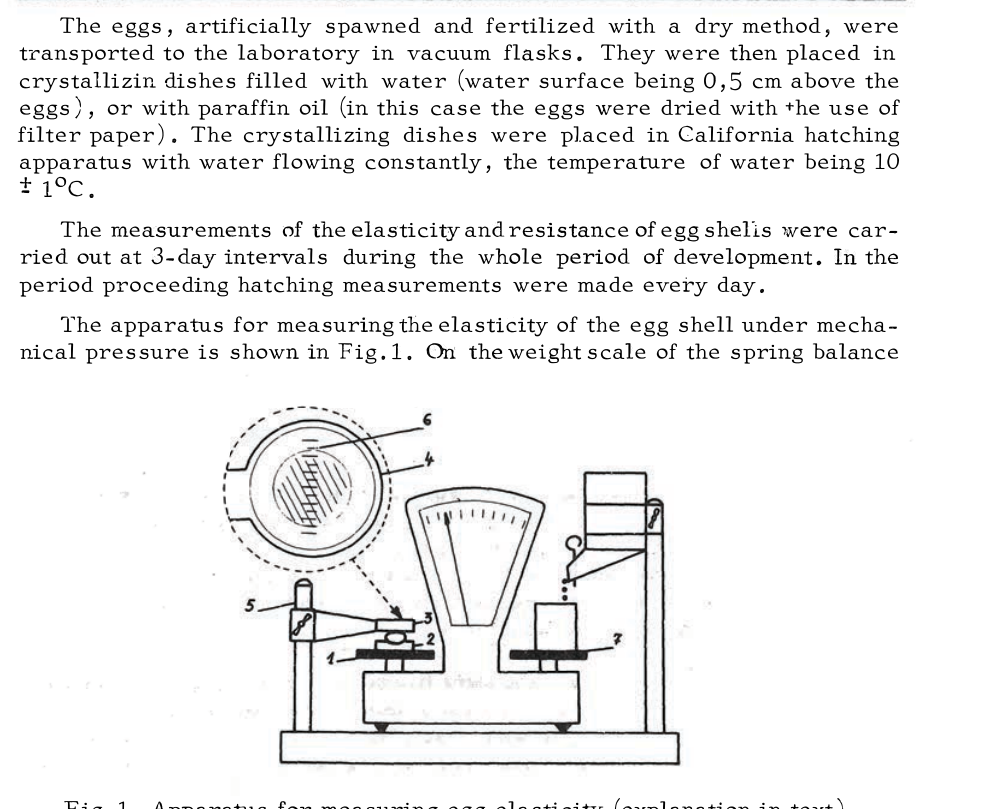
Fig .1. Apparatus for measuring egg elasticity (explanation in text) (1) a small